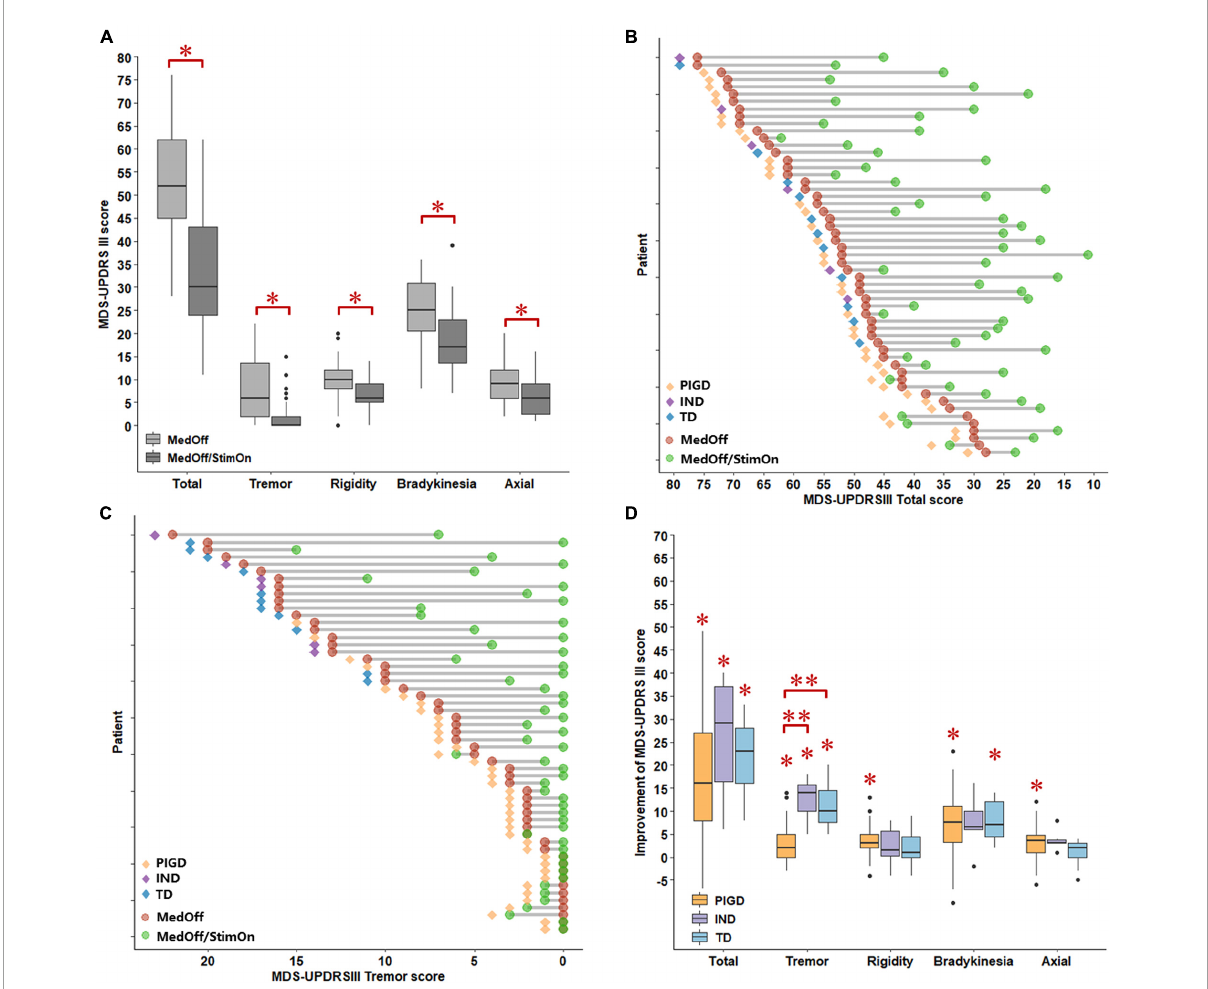
FIGURE1 Comparisons of MDS-UPDRS III scores between baseline MedOff and MedOff/StimOn states in 1 year follow up (A) . Individual changes of MDS-UPDRS III scores between baseline MedOff (red point) and MedOff/StimOn (green point) states with PIGD (orange rhombus), IND (purple rhombus) and TD subtypes (blue rhombus) (B) . Individual changes of MDS-UPDRSIII tremor scores between baseline MedOff (red point) and MedOff/StimOn (green point) states with PIGD (orange rhombus), IND (purple rhombus) and TD subtypes (blue rhombus) (C) . Postoperative improvement of the MDS-UPDRS III between baseline MedOff and MedOff/StimOn for the patients with PIGD, IND, and TD subtypes (D) . For the boxplots of (A,D) , the central line depicted the median, the top and the bottom of the box indicated the 75th quantile (Q3) and 25th quantile (Q1), the top and the bottom of the error bar stated the “maximum” (Q3 + 1.5 × interquartile range) and the “minimum” (Q1–1.5 × interquartile range), dots represented the outliers. ∗ Indicate significant differences between baseline MedOff and MedOff/StimOn states. ∗∗ Indicate significant differences between the two groups. MDS UPDRS-III, movement disorder society unified Parkinson’s disease rating scale-motor part; MedOff, preoperative off-medication state; MedOff/StimOn, postoperative off-medication/on-stimulation state; PIGD, postural instability and gait difficulty; IND, intermediate; TD, tremor